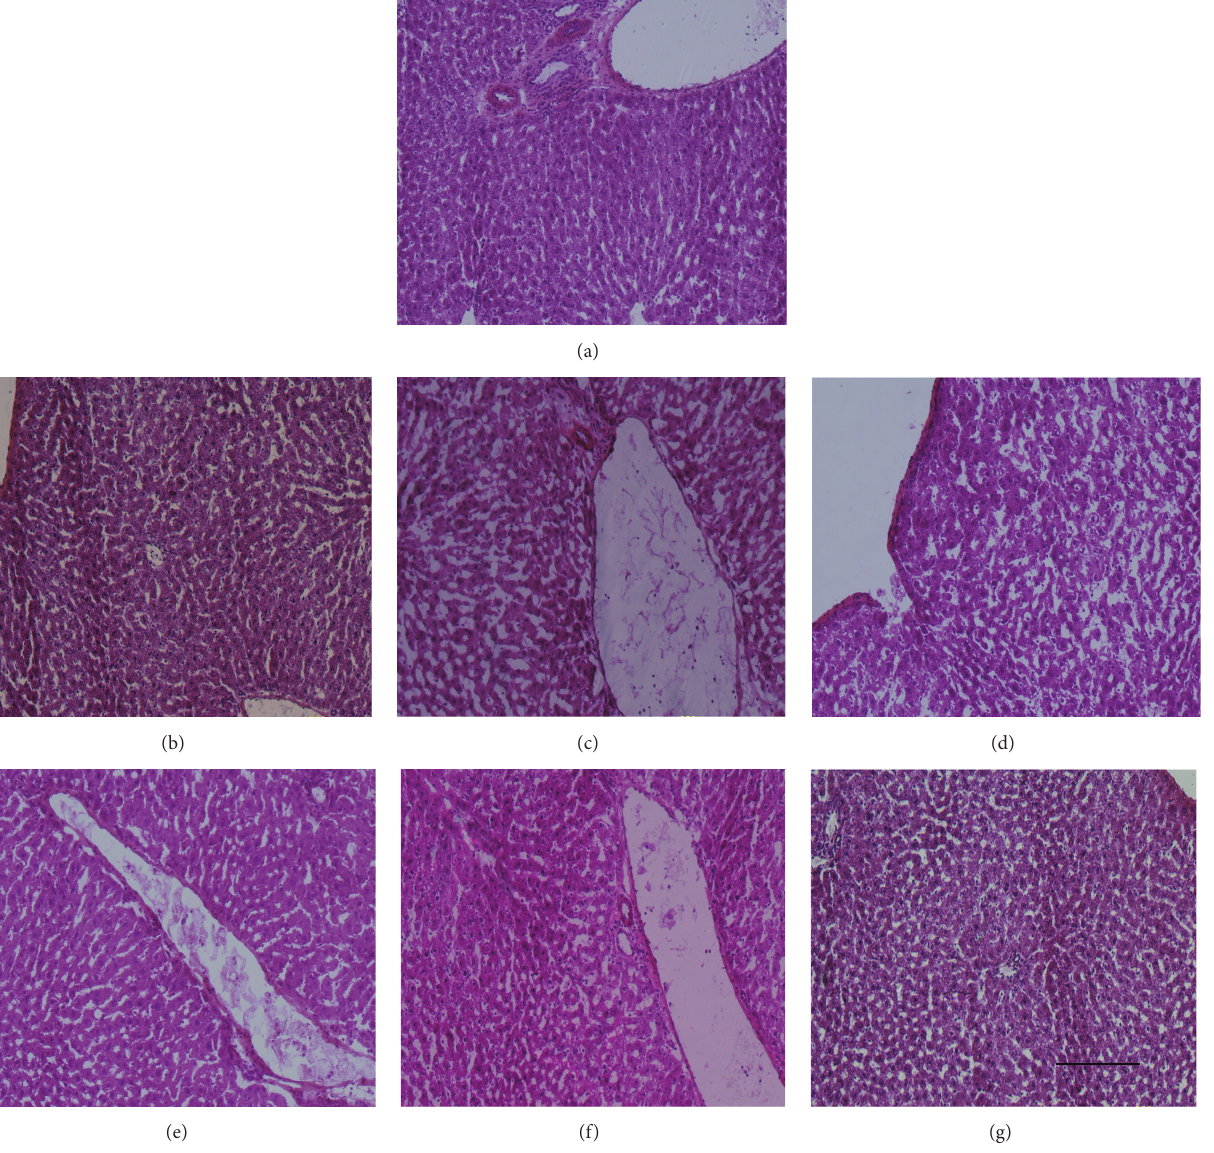
Figure 3: Hematoxylin and Eosin staining of liver sections. (a) Normal liver; (b–g) G1 to G6. Original magnification,